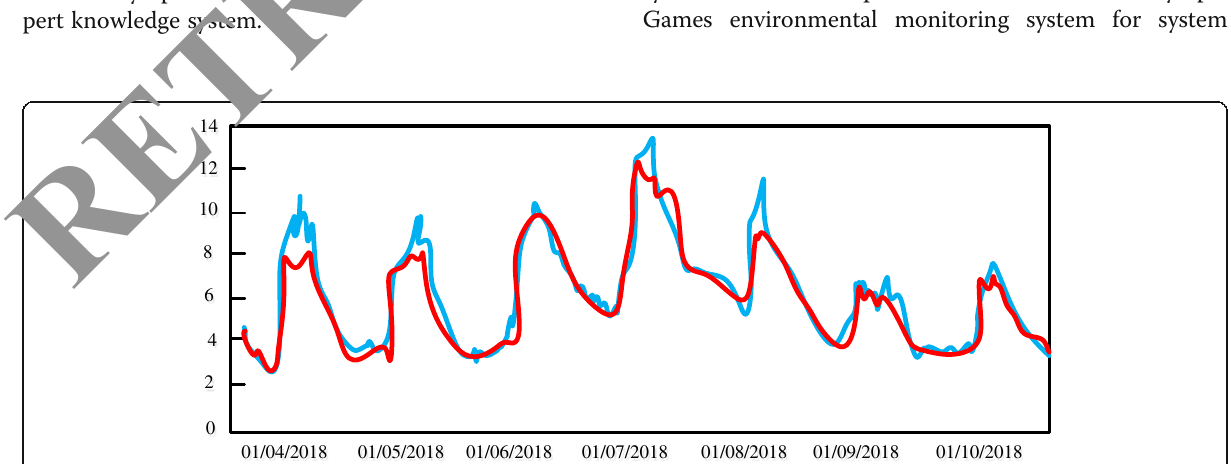
Fig. 5 The environmental temperature curve collected by the